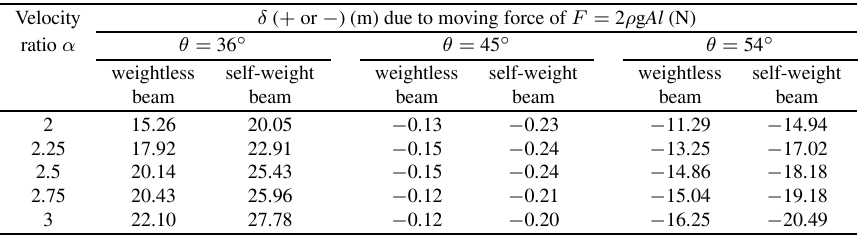
Table 3 δ variation in targeting of planar projectile onan inclined Timoshenko beam for various α using nonlinear analysis for moving force model; ( v cr = 131.60